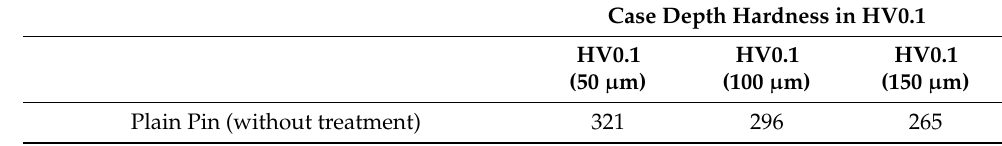
Table 2. Microhardness of untreated